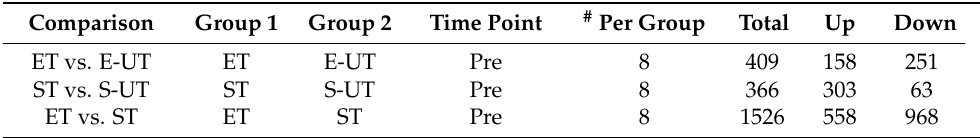
Table 3. Number of genes differentially expressed between ET vs. E-UT (409 genes), ST vs. S-UT (366 genes) and ET vs. ST (1526).